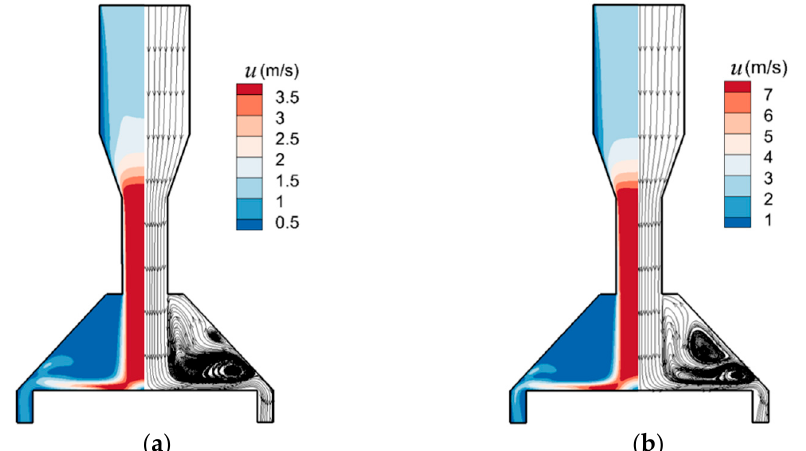
Figure 4. The fluid velocity and streamline of cross-section view of the model. ( a ) Re = 400, stk = 0.25. ( b ) Re = 700, stk = 0.25.